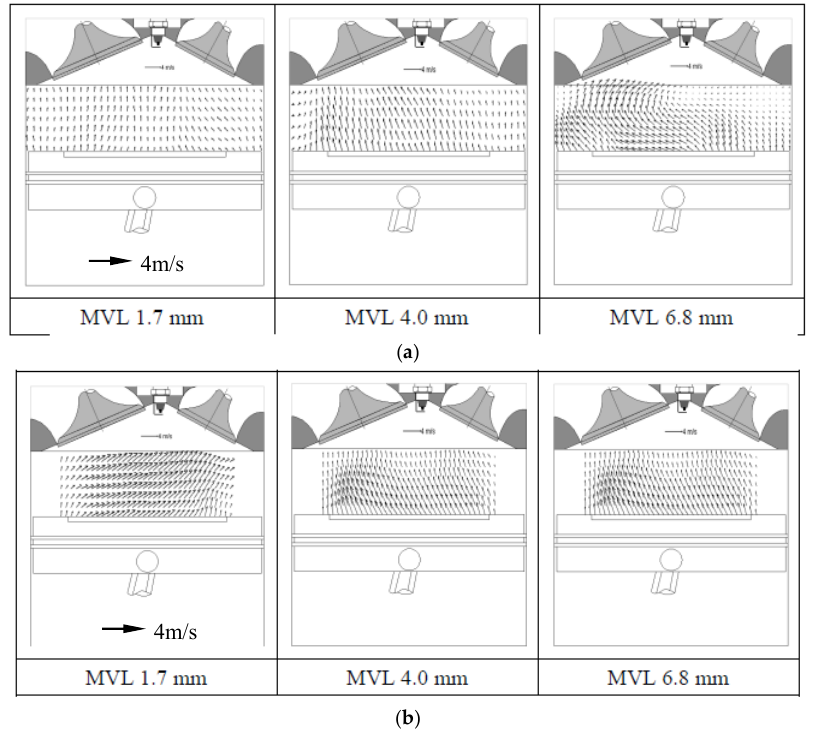
Figure 13. Tumble flow ensemble ‐ averaged flow fields at 300 °CA (near the compression end) for MVL 1.7 mm, 4.0 mm and 6.8 mm: ( a ) at Plane 1 and ( b ) at Plane 2.